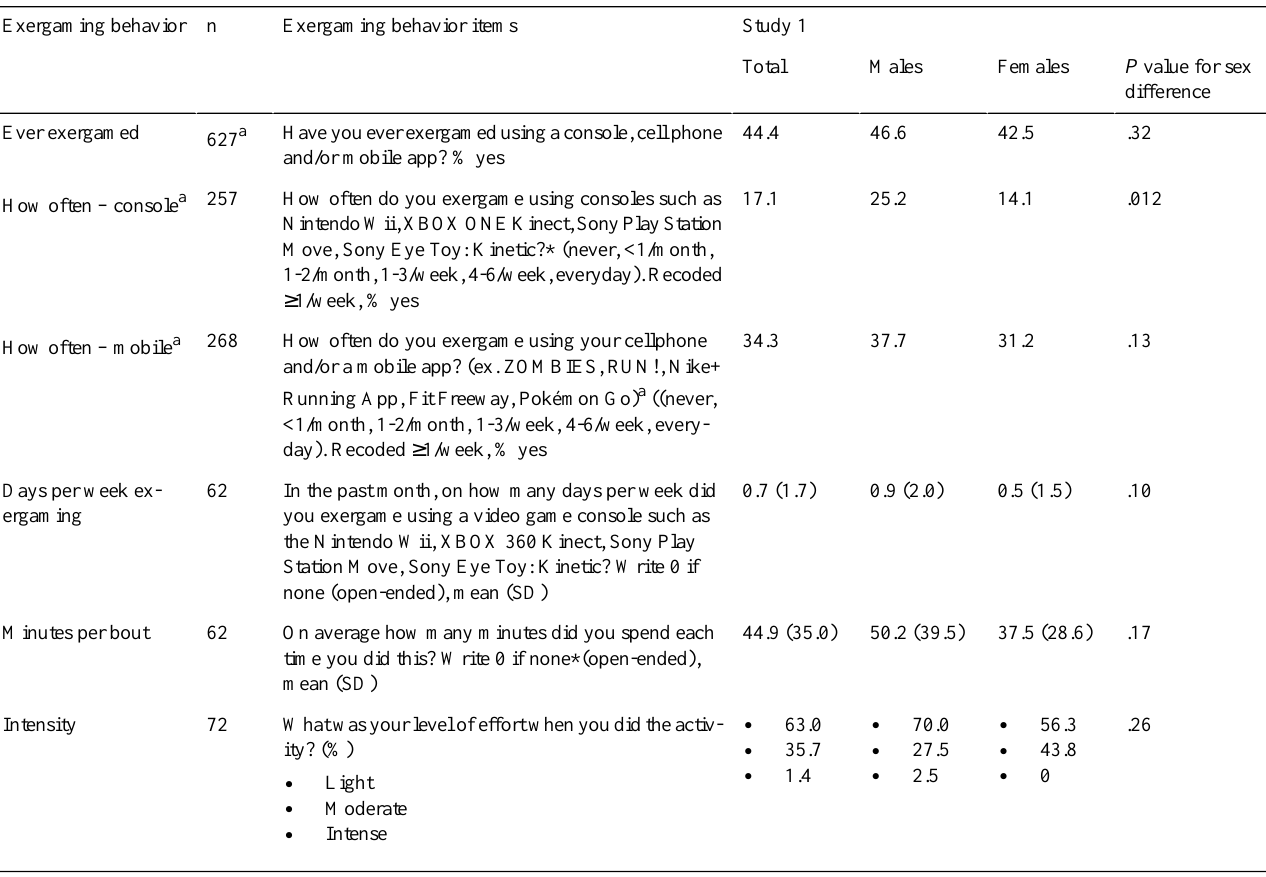
Table 5. Items measuring exergaming behavior by sex in Study 1, NDIT 2017-2019.